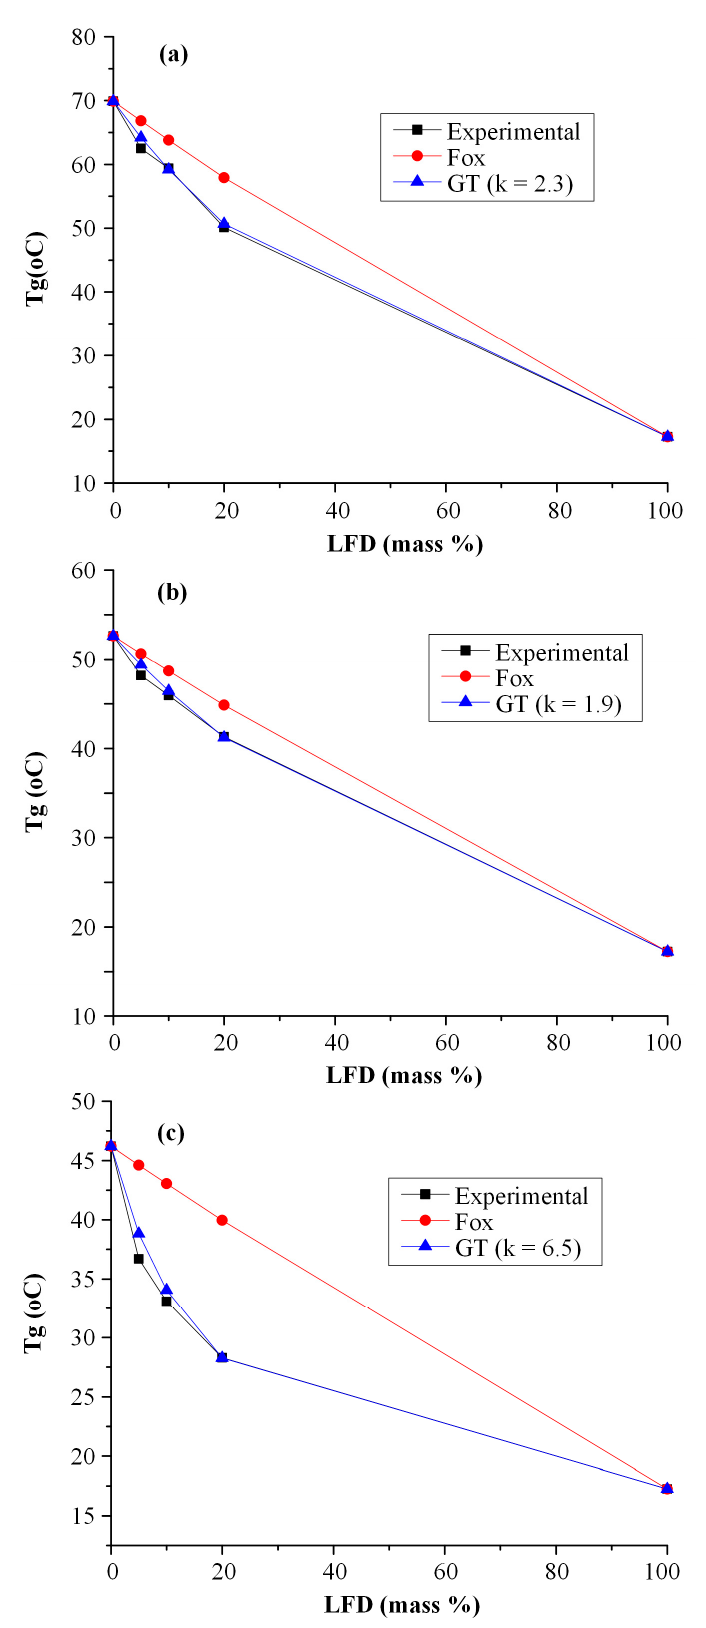
Figure 8. Prediction of Tg-composition dependence in LFD-PLLA ( a ), LFD-PLGA 75/25 ( b ), and LFD-PLGA 50/50 ( c ) thin-films by Fox and Gordon-Taylor (GT)